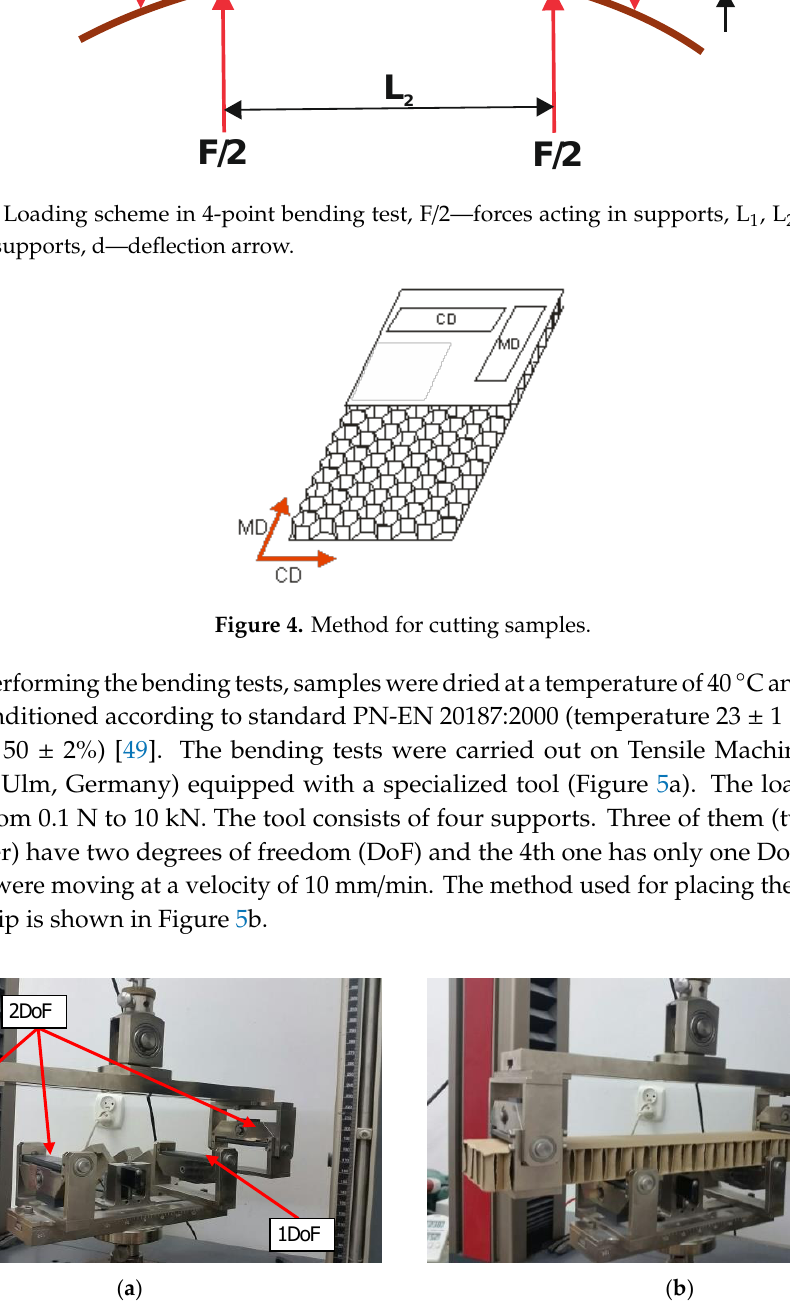
Figure 3. Loading scheme in 4-point bending test, F/2—forces acting in supports, L 1 , L 2 —distance between supports, d—deflection arrow.